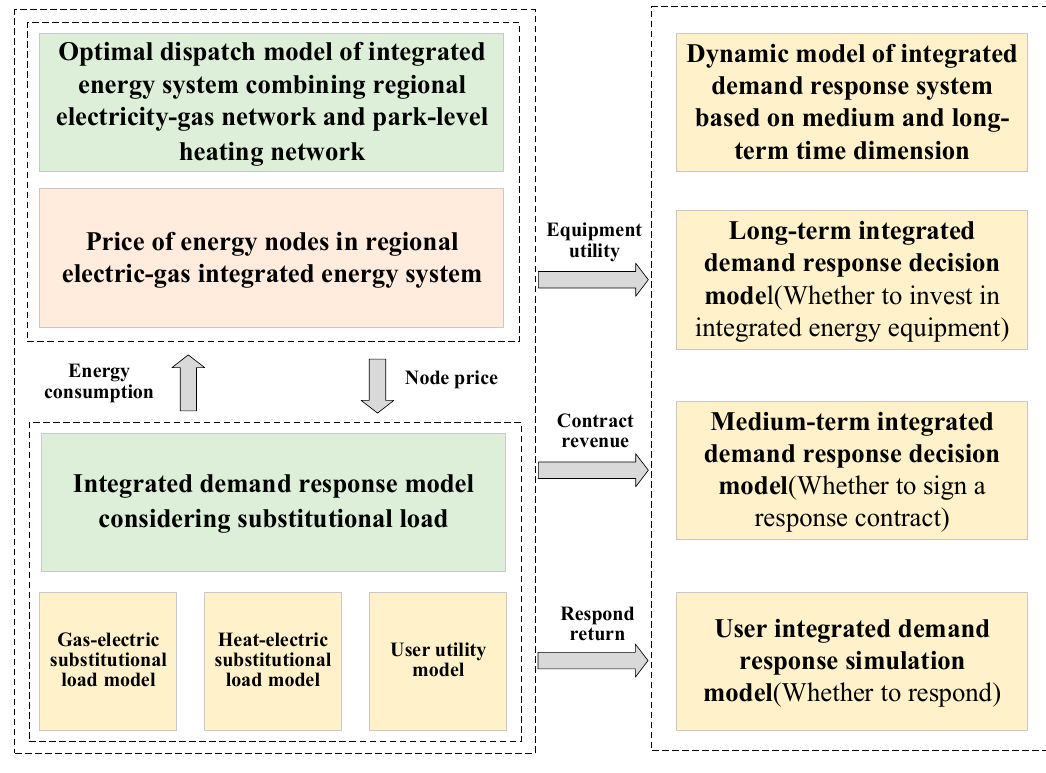
Figure 6. Modeling schematic.